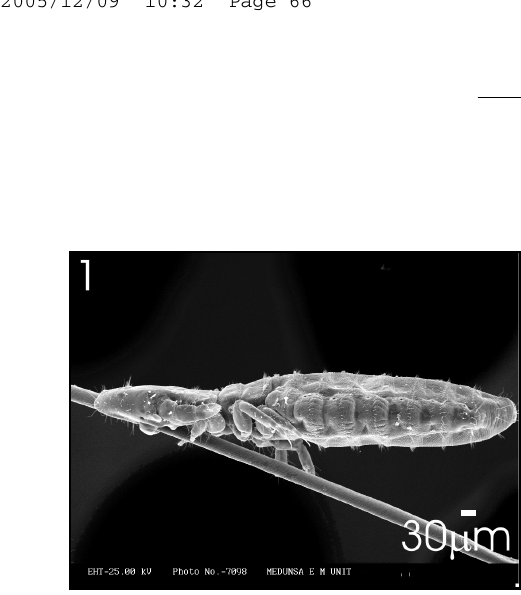
Fig. 1. A SEM micrograph of Damalinia crenelata anchored to a hair of a